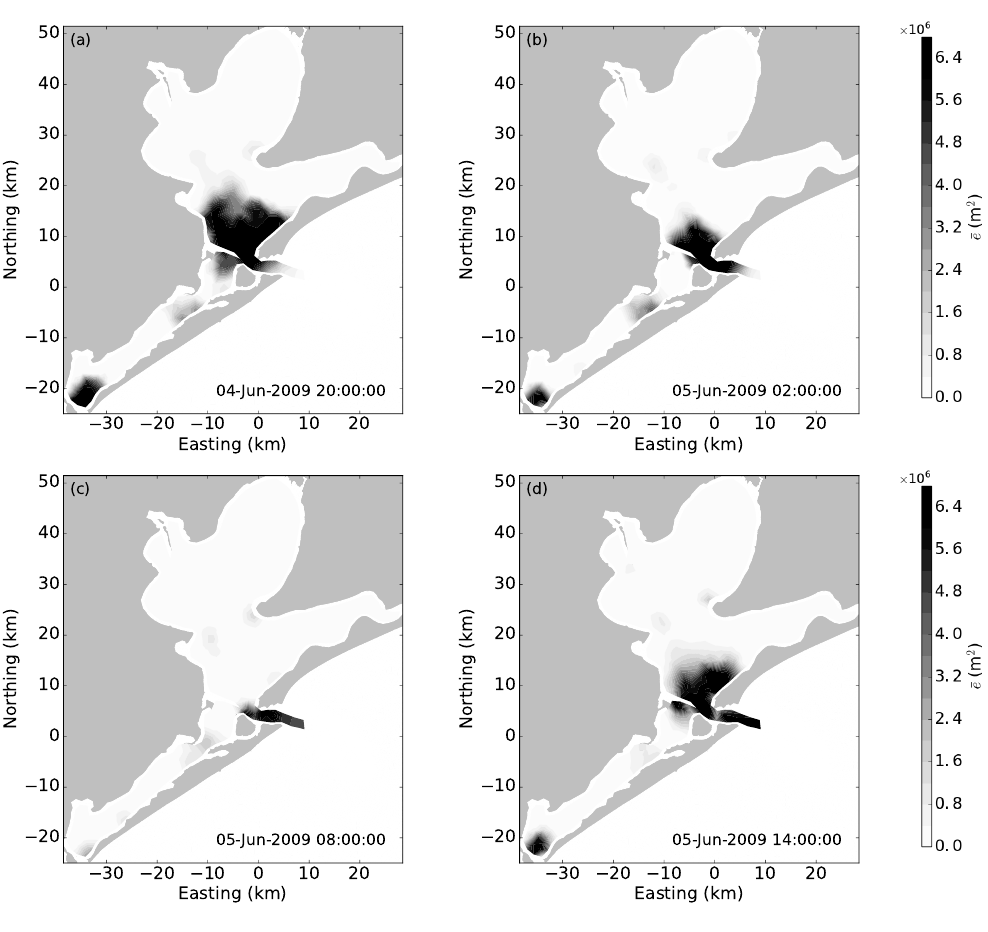
Figure 5. Spatial distribution of the diffusion area error (¯ e ) at four flow conditions: ( a ) maximum flood tide, ( b ) moderate flood tide, ( c ) weak ebb tide (near slack water), and ( d ) maximum ebb